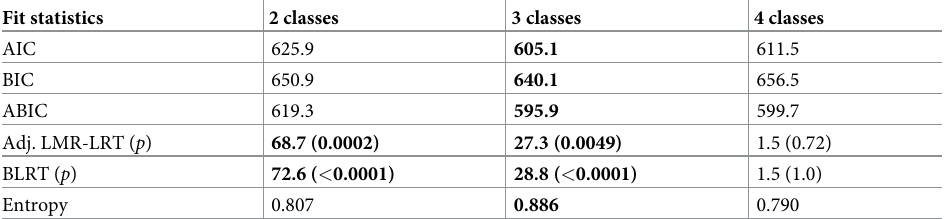
Table 1. Fit statistics for latent profile models of psychosocial stress among women in the Women’s Interagency HIV Study, Washington, DC, 2019–2020 (n = 90).